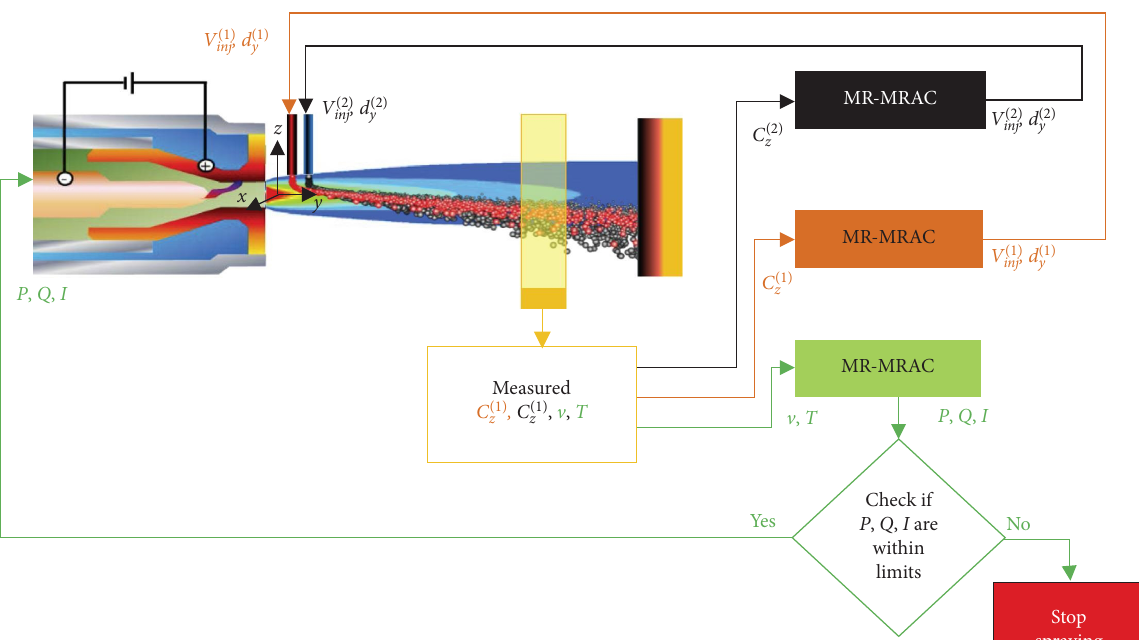
,C ( 2 ) � measured number averaged z – locations of z z d ( 1 ) ,d ( 2 ) � y – locations of NiCrAlY and ZrO 2 particles, respectively; y y